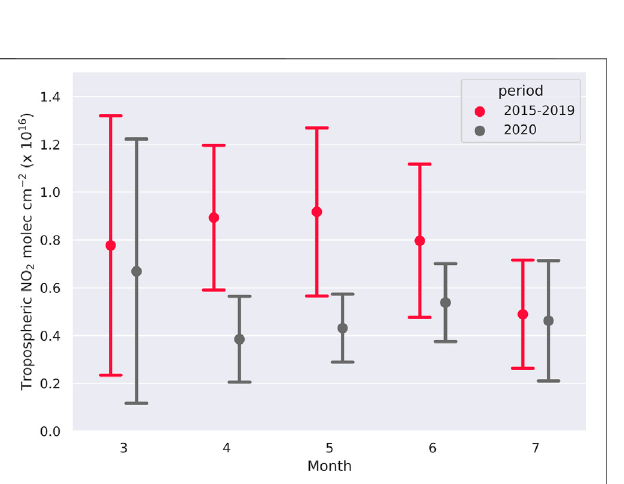
FIGURE4| OMIretrievals oftroposphericNO 2 columnoverDelhiduring months corresponding to COVID-19 lockdown and unlock phases during 2020 and comparison with previous